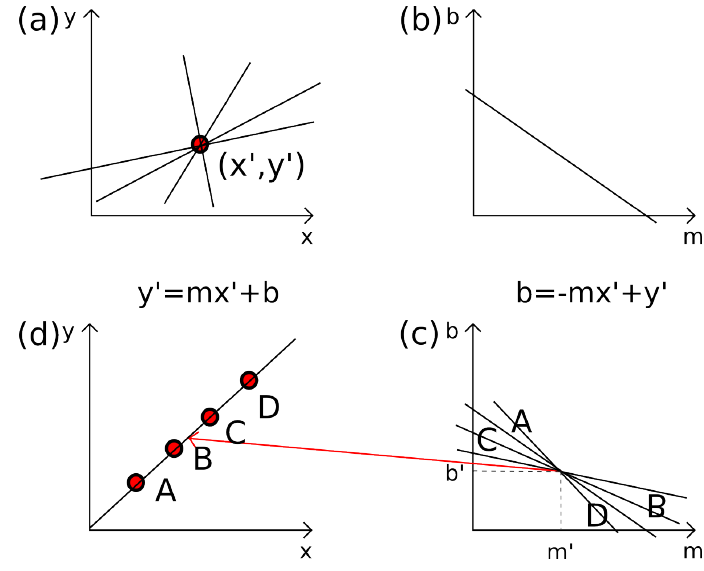
Figure 1. Principle of the Hough transform: An arbitrary point ( x (cid:48) , y (cid:48) ) in a coordinate system is intersected by lines with arbitrary slopes m and y-offsets b ( a ). All lines are described by one parameter line ( b ). The parameter lines ( c ) belong to a chain of corresponding points ( d ). The points are connected via a line with the slope m (cid:48) and the y-intersect b (cid:48) indicated by a red